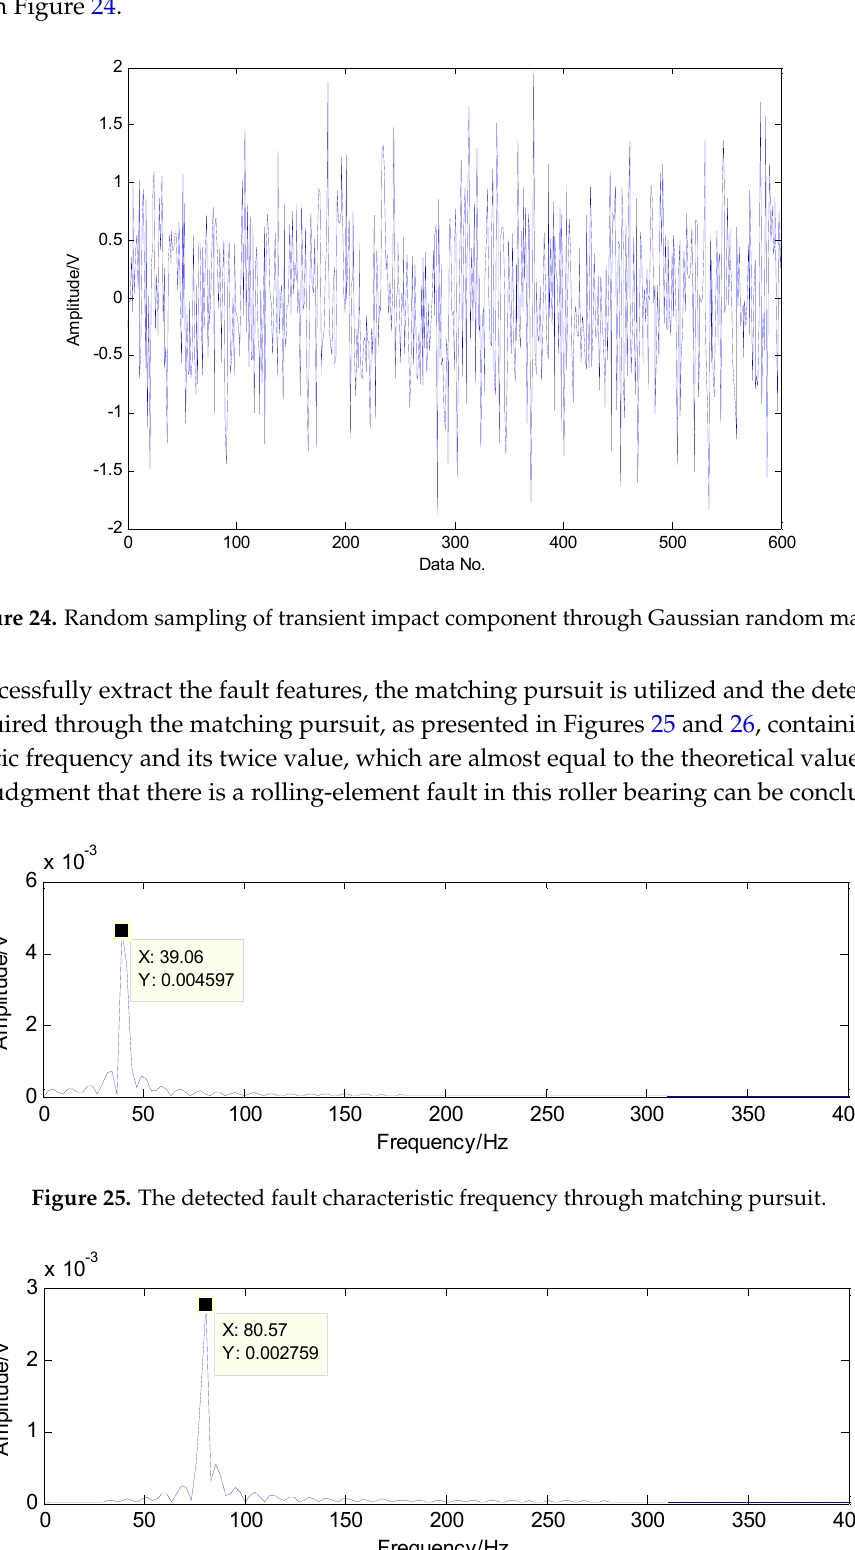
Figure 23. Envelope spectrum of the transient impact component in Figure 20.